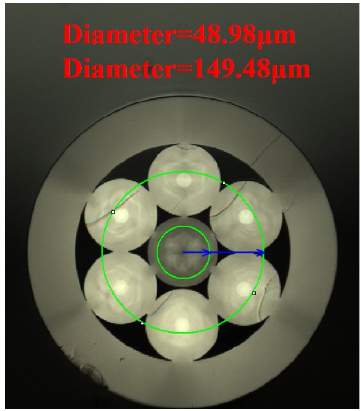
Figure 4. The cross-section of taper-fused bundle.